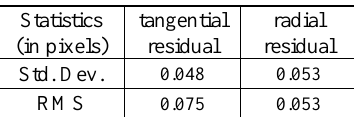
Table 2. Image residual from the calibration